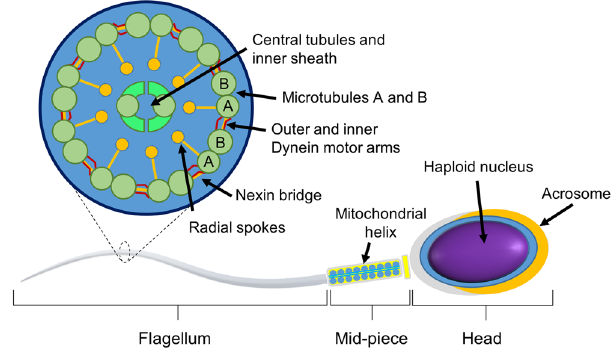
Figure 1. Cartoon depiction of a sperm showing: (i) the head, containing the haploid nucleus and capped with the acrosome for breakdown of the zona pellucida; (ii) mid-piece, comprised of a mitochondrial sheath; and (iii) flagellum, axoneme of the flagellum extends from the posterior of the head comprised of microtubules surrounded by a plasma membrane. Dynein motor proteins and nexin linkages span between microtubules A and